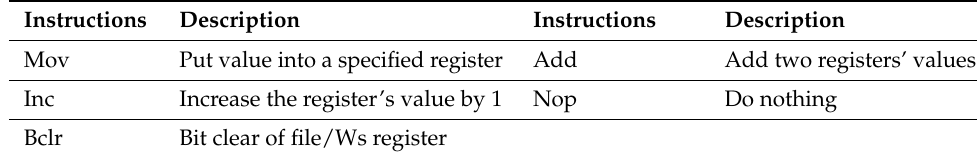
Table 3. dsPIC33EP512MC202 instruction introduction.